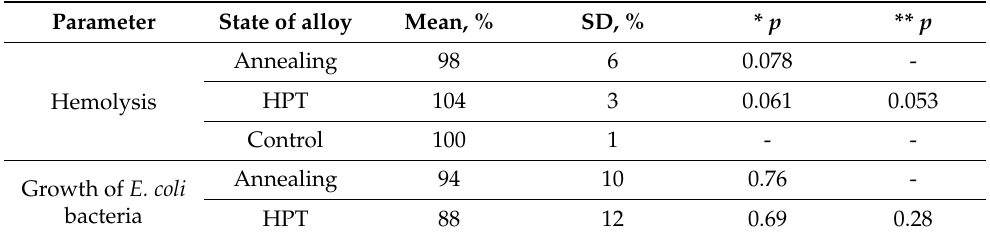
Table 3. Hemolytic activity of RBCs and growth of E. coli with samples of the annealed and HPT- treated alloy in comparison with control (SD — standard deviation; * the difference from the control; ** the difference from the alloy after HPT treatment).